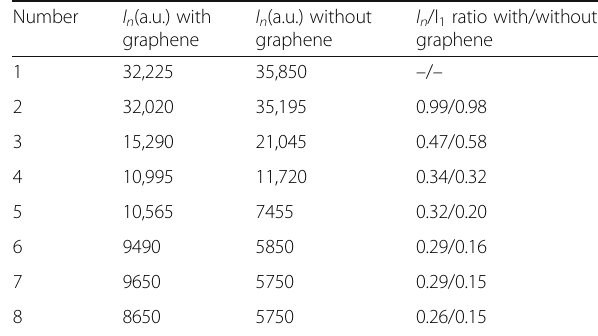
Table 1 Information about the intensity of the O1s spectrum peak with and without graphene after various annealing steps, as extracted from Fig.